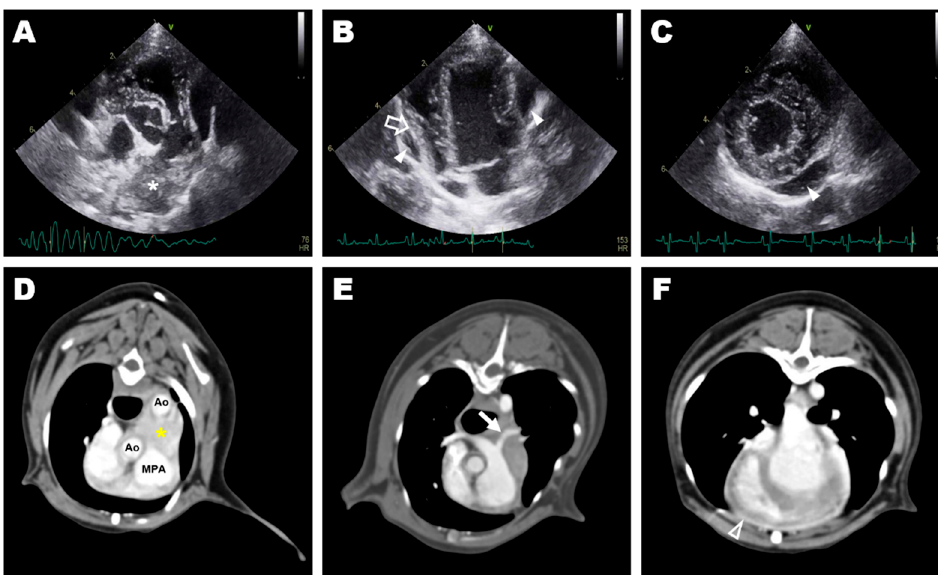
Figure 1. Preoperative diagnostic imaging: transthoracic echocardiography ( A – C ) and transverse image of computed tomography ( D – F ); ( A ) hyperechoic mass (asterisk) at the bifurcation of the main pulmonary artery identified at aortic root level short-axis view of the right parasternal win- dow; ( B ) pericardial effusion (arrowhead) and deviated free wall of the right ventricle (blanked arrow) identified at the apical four-chamber view of the left parasternal window; ( C ) small amount pericardial effusion (arrowhead) identified at the short-axis view of the right parasternal window; ( D ) a heterogeneous lesion (yellow asterisk) in the anterior heart base between the aorta and the main pulmonary artery; ( E ) stenosed left pulmonary artery (arrow) caused by compression of the heart base mass; ( F ) thickened pericardium with post-contrast enhancement (blanked arrowhead).